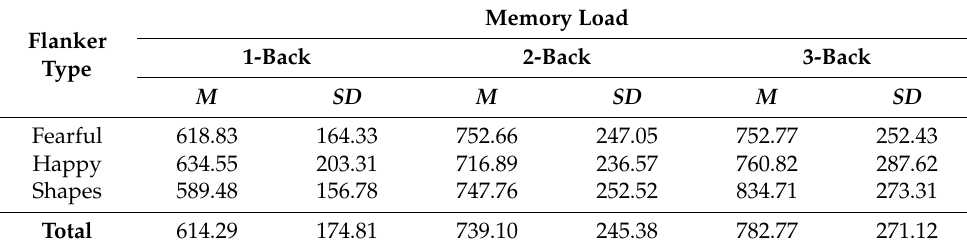
Table 10. Descriptive statistics of participants’ mean reaction times for hits (before log-transformed) for Study